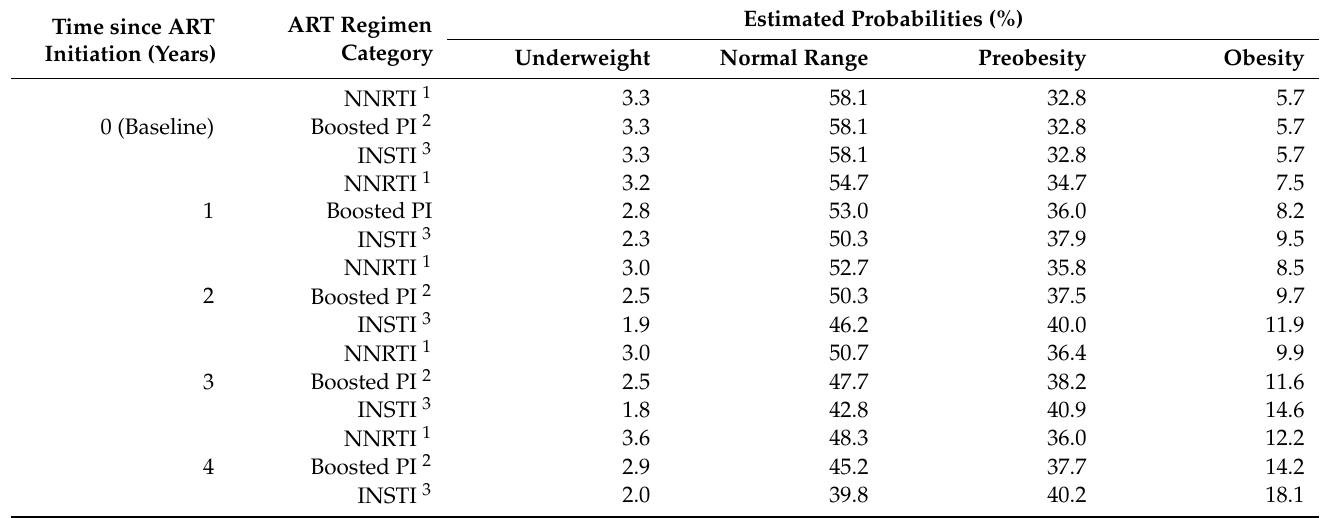
Table 3. Estimated probabilities of belonging to one of the body mass index WHO categories by time since ART initiation and ART regimen category. Estimates shown for men having sex with men, aged 30 – 39, with no AIDS and with 10,000 – 49,999 HIV-RNA copies/mL at baseline. Estimated Probabilities (%)